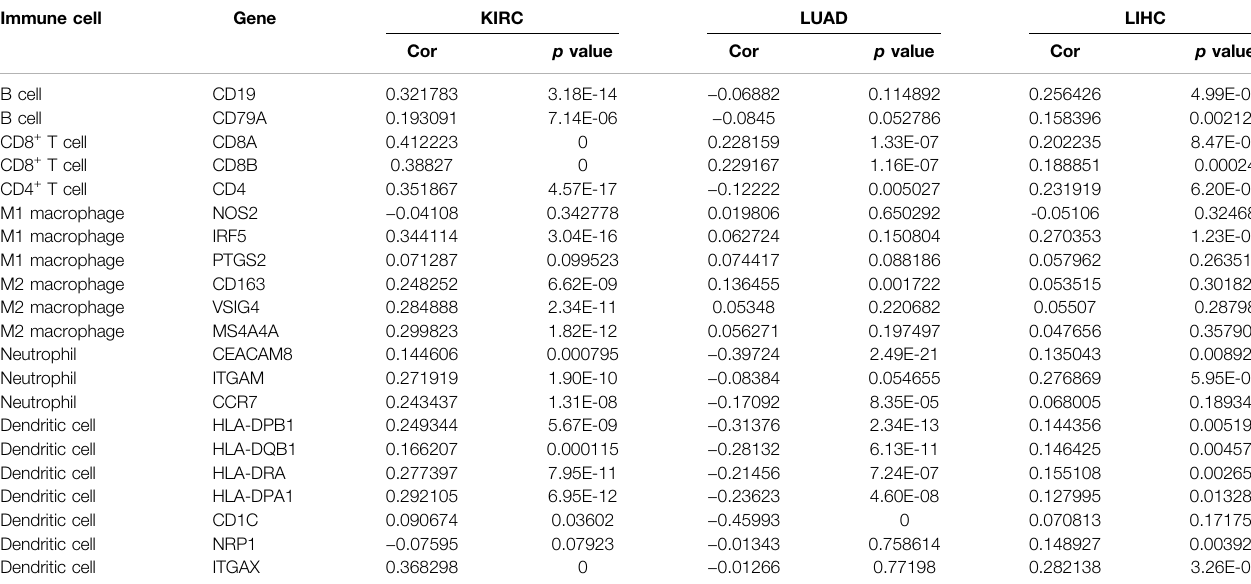
TABLE 5 | Correlation between CCNA2 and the immune cell biomarker. Immune